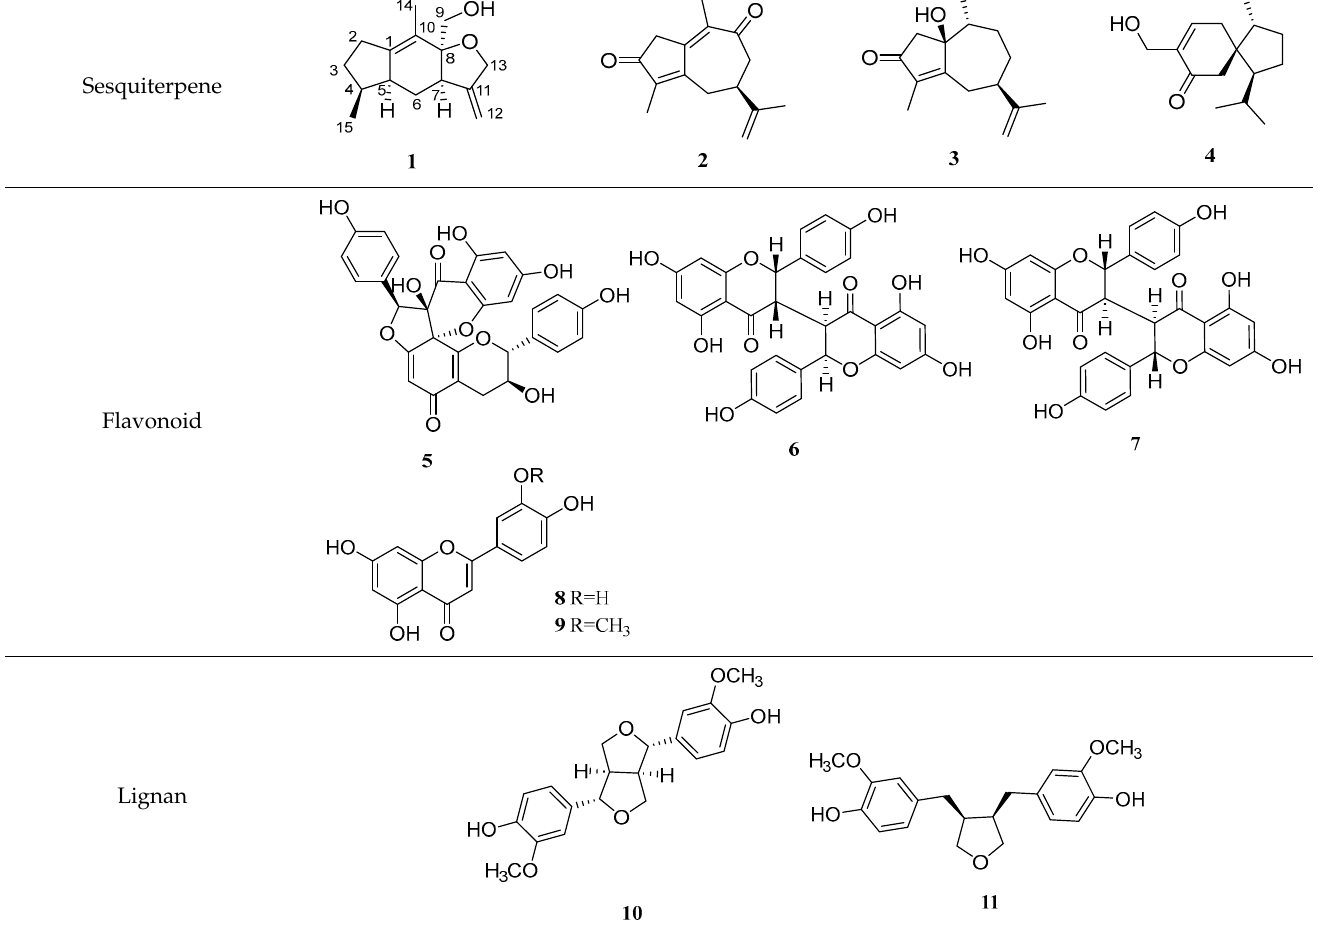
Table 1. Chemical constituents from the roots of Wikstroemia chamaedaphne .